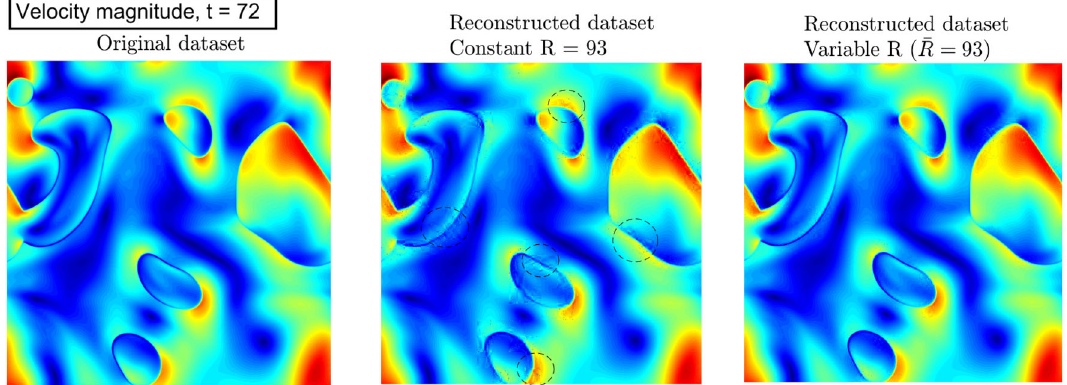
Fig. 13 Plots showing ( left ) the original velocity magnitude U field; the field is represented on 3200 (cid:6) 3200 regular grid distributed on 20 (cid:6) 20 processes, ( middle ) its reconstructed version using a constant compression ratio R throughout its processes and ( right )